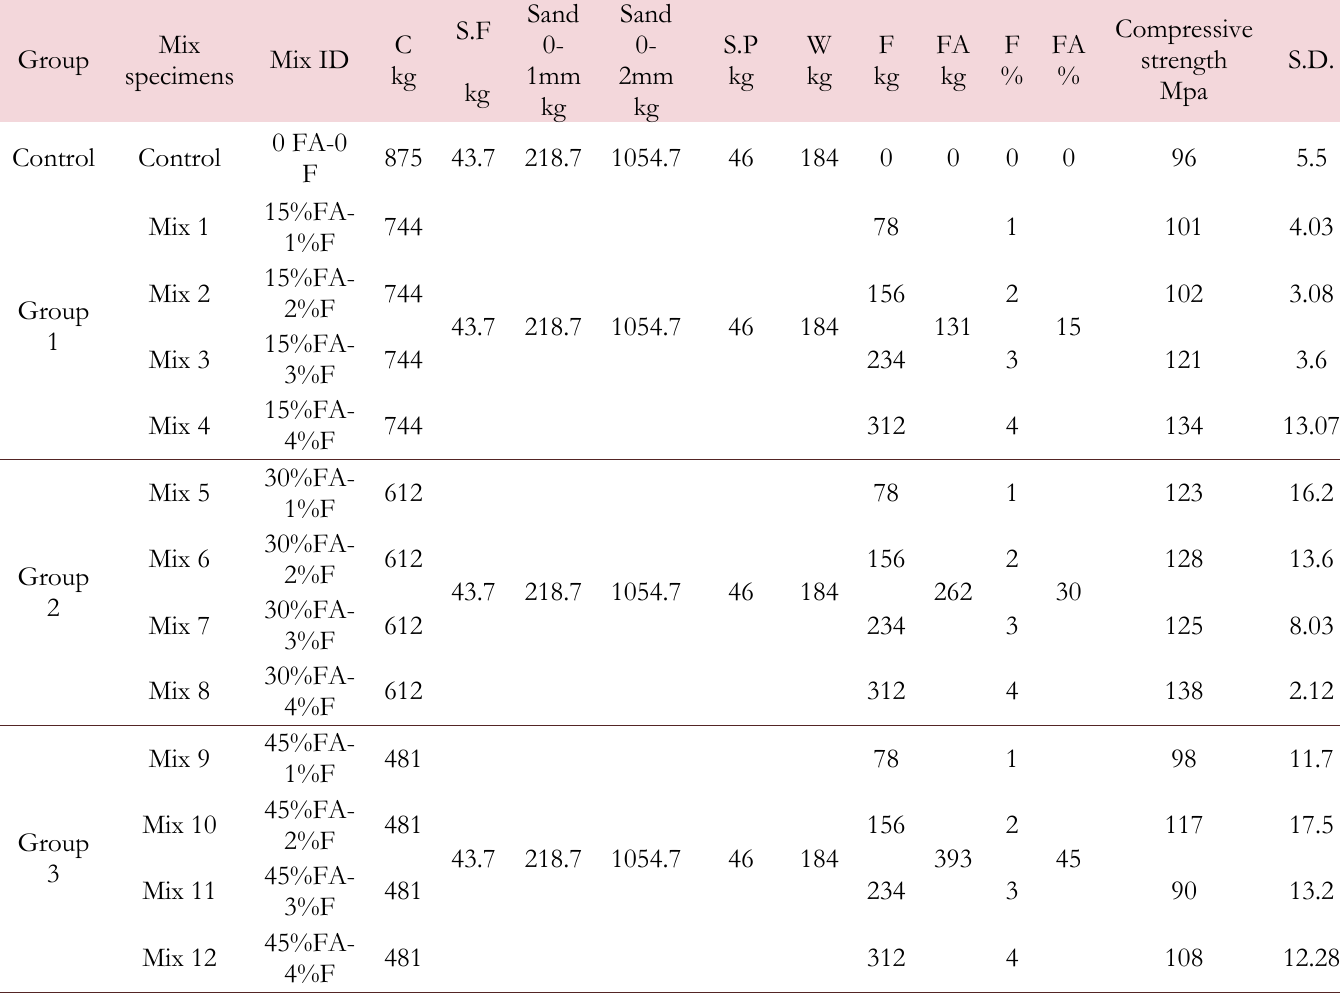
Table 3: Mix content of the tested thirteen beams. C: Cement, SF: Silica fume, S.P.: Superplasticizer, W: water, F: Steel fiber, FA: Fly ash, and S.D.: Standard